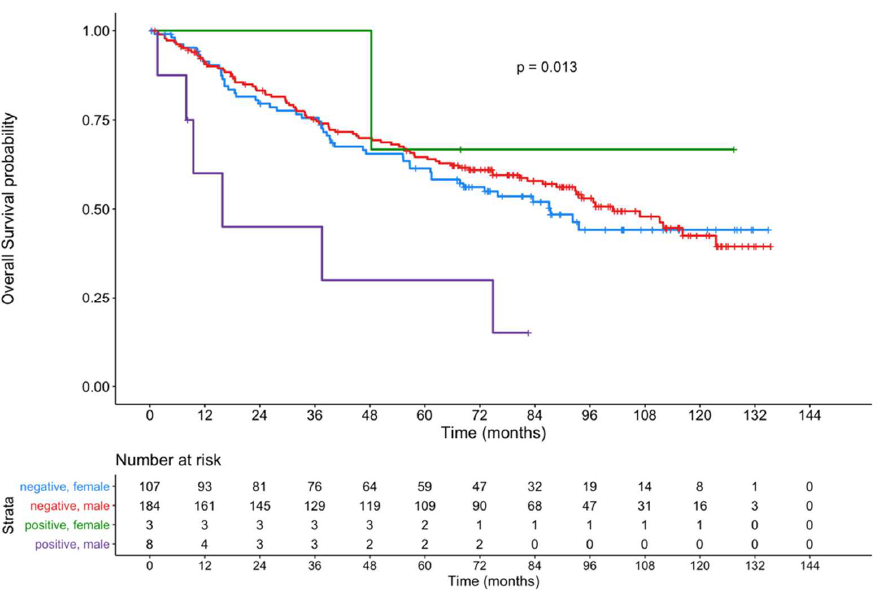
Figure 5. Kaplan–Meier curves showing the OS of male and female patients with an ERα-positive primary tumor compared to patients with ERα-negative tumors. primary tumor compared to patients with ER α -negative